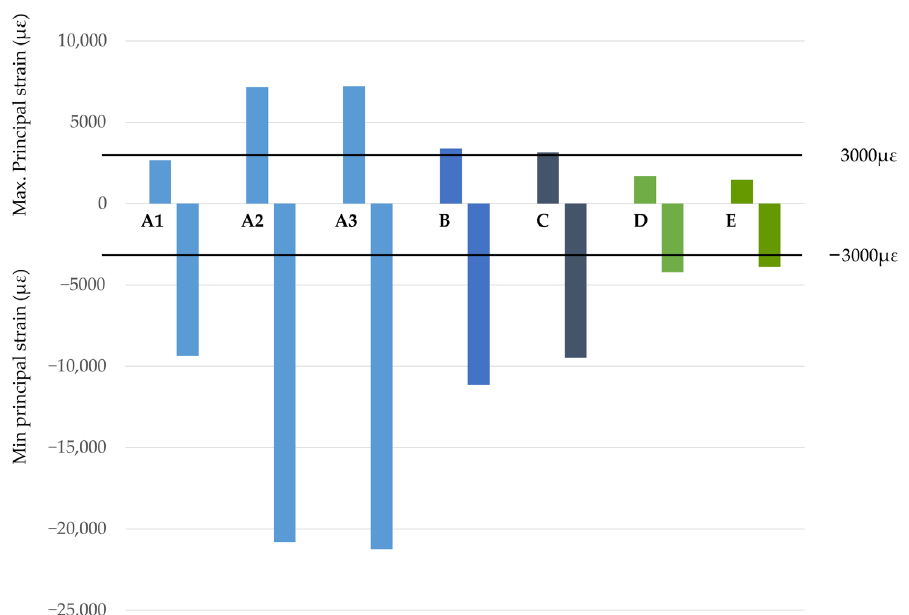
Figure 5. Maximum values for the max. principal strain ( µε ) and minimum values for the min. principal strain ( µε ). Blue shades—cases with implants between foramina. Green shades—cases with the 2 implants posterior to the distal of the foramen.